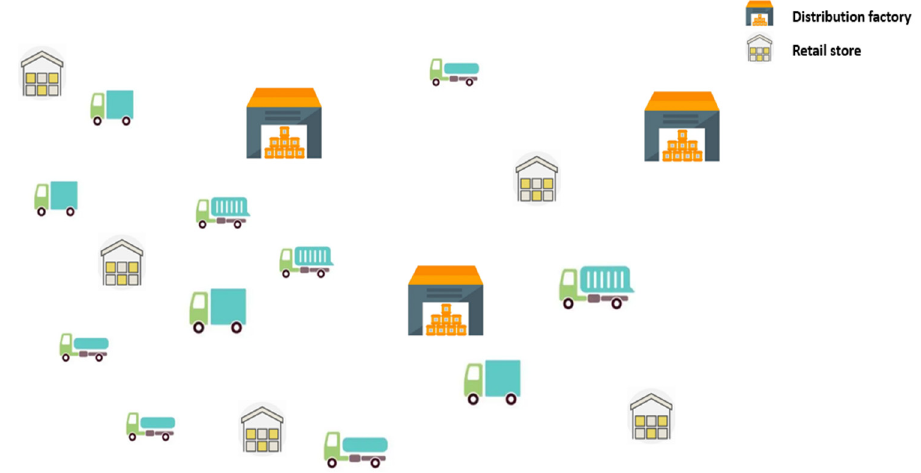
Figure A1. Distribution of the order locations and driver locations.